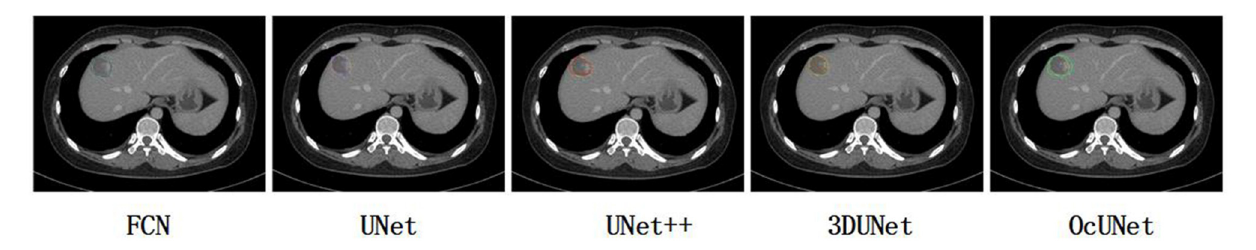
FIGURE 5 | Example of tumor segmentation results from a testing